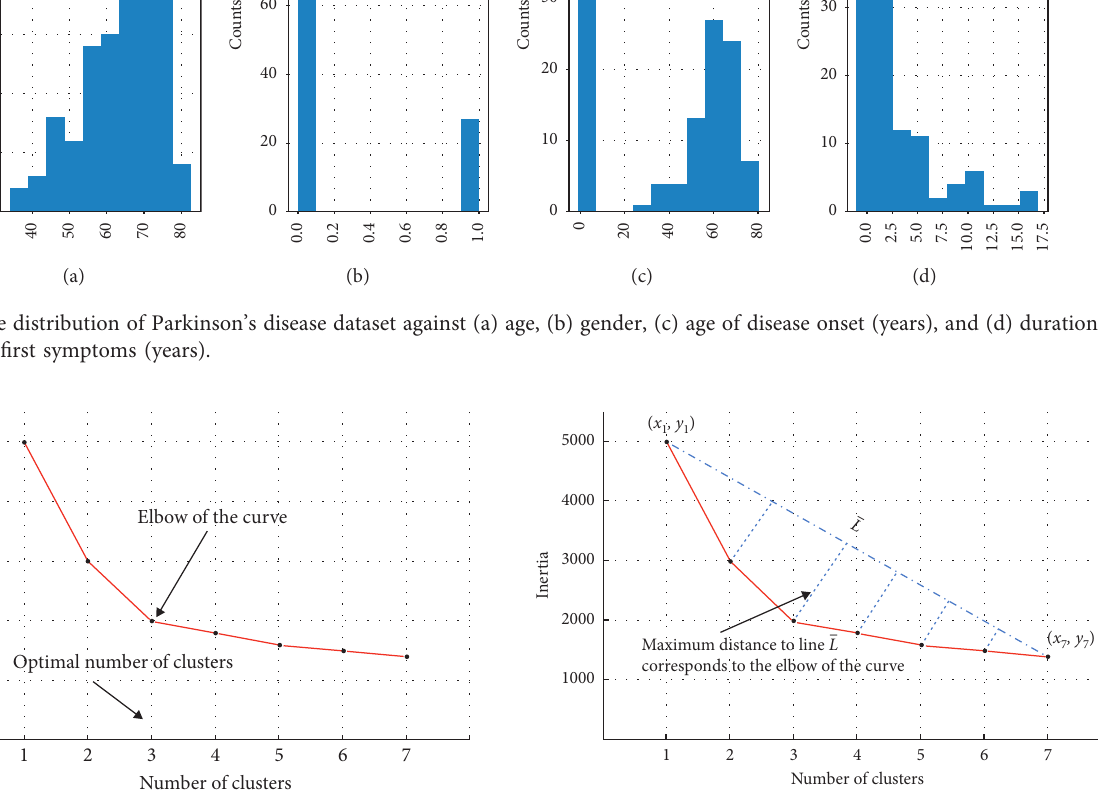
Figure 3: The relation between the number of clusters and inertia. The optimal number of clusters corresponds to the elbow of the curve.